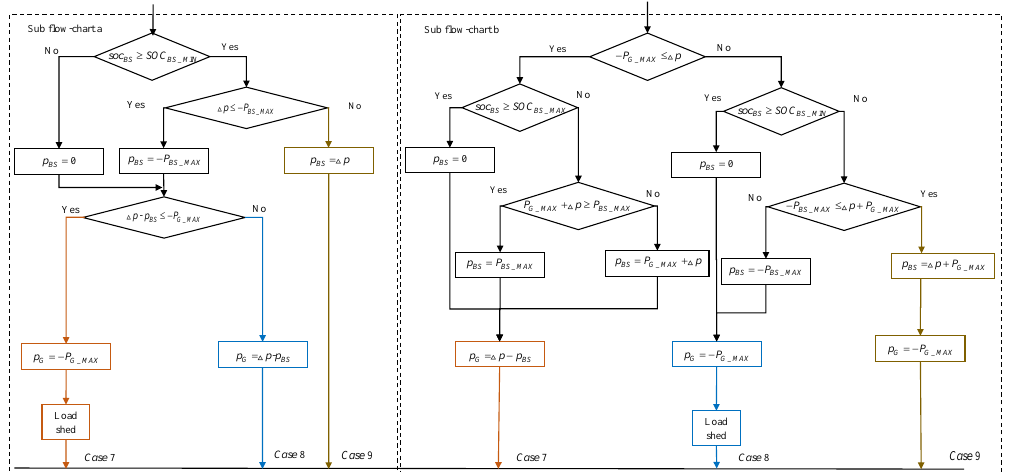
Figure 5. Sub-flowchart a and sub-flowchart b.